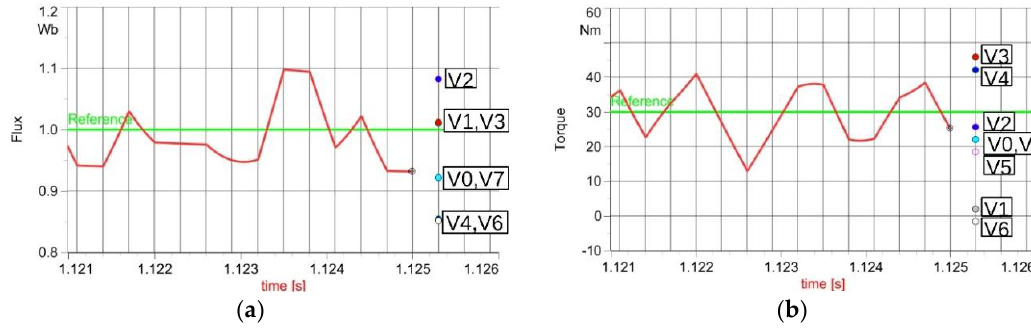
Figure 9. ( a ) Flux amplitude waveform in the PTC run. ( b ) Torque waveform in the PTC run. Predicted effects of all possible voltage vectors are shown for both waveforms. In this case, the chosen vector was V2. Table 5. Cost function results.